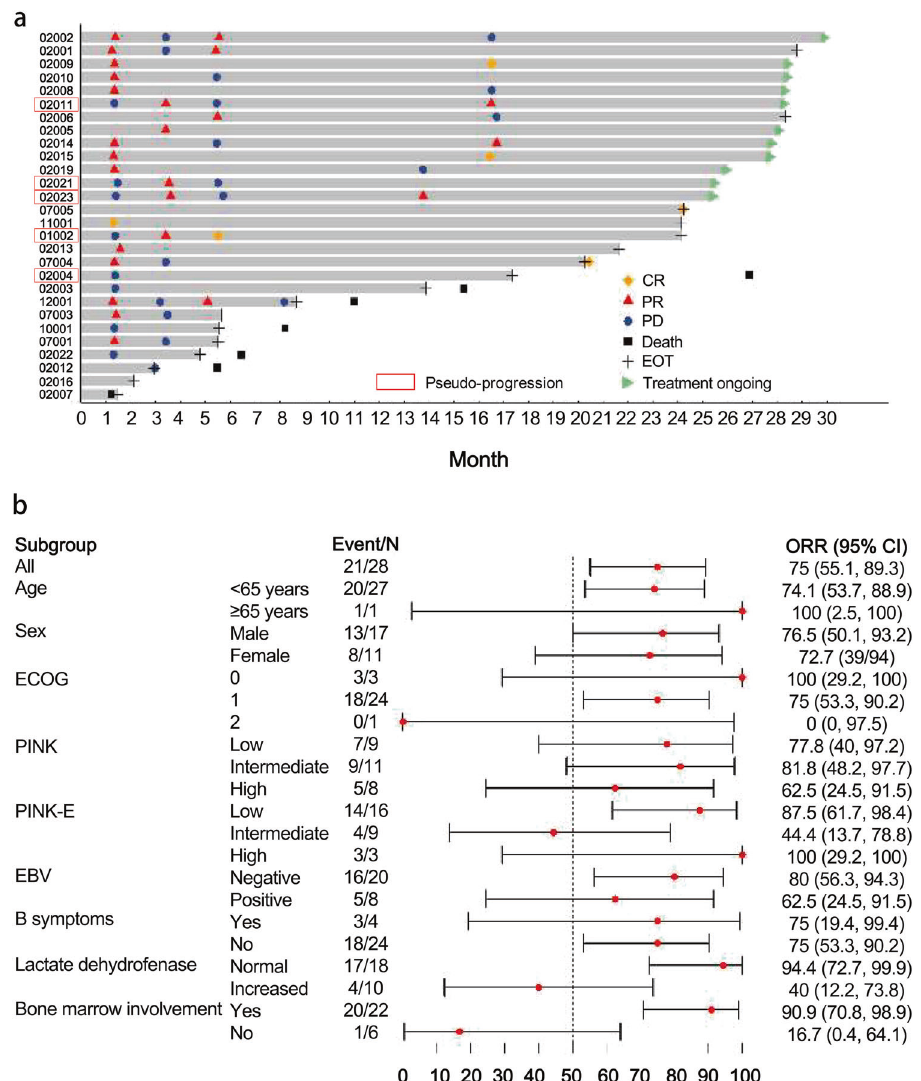
Fig. 1 Response to sintilimab in patients with relapsed/refractory NK/T cell lymphoma. a Analysis of time to response and duration of response. Patient 02004 was evaluated as stable disease after experiencing pseudo-progression. b Subgroup analysis of